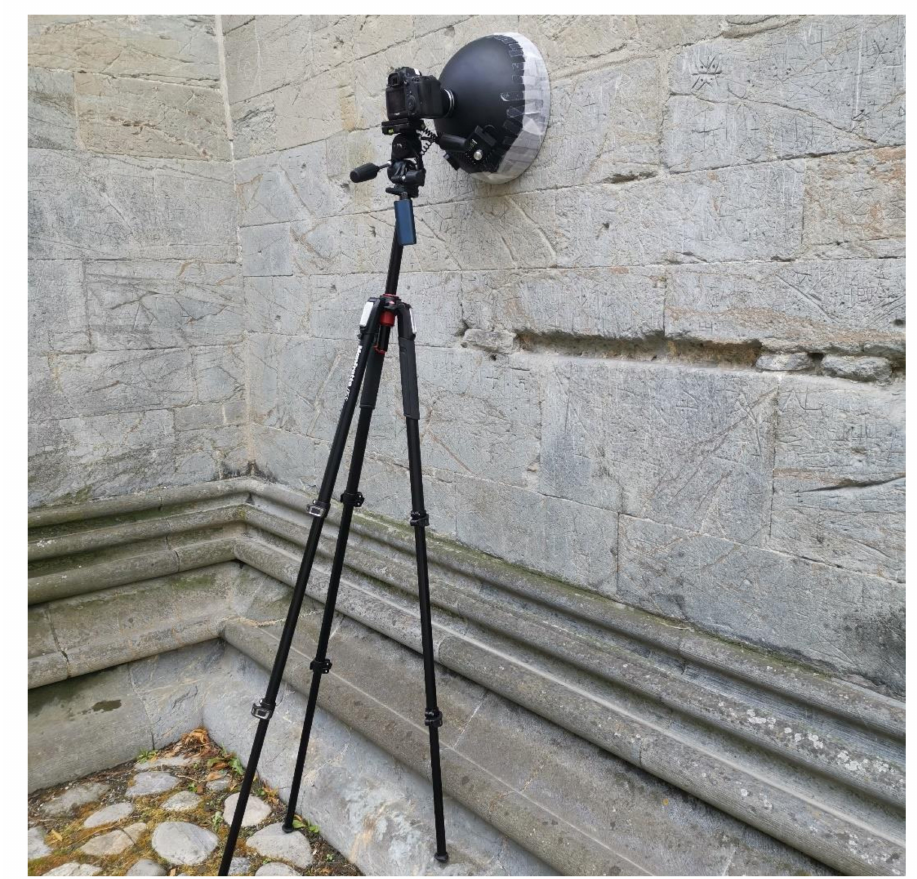
Figure 2. Image acquisition of Surface B, on a 13th century building stone still in original